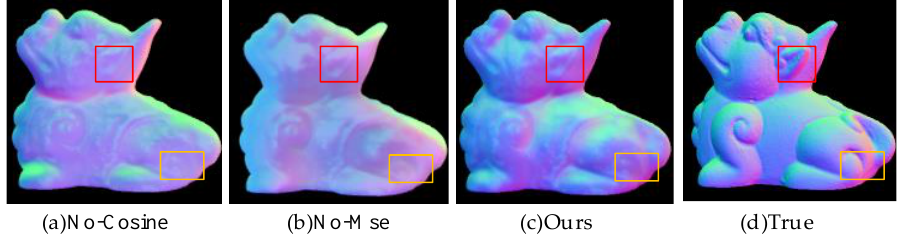
Figure 11. Validation of content loss. The red and yellow boxes can be used to compare the differences in texture and color information brought by these three